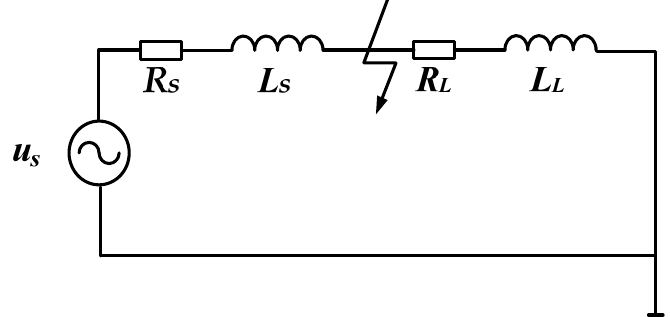
Figure 1. Basic model for single-phase earth short-circuit faults.